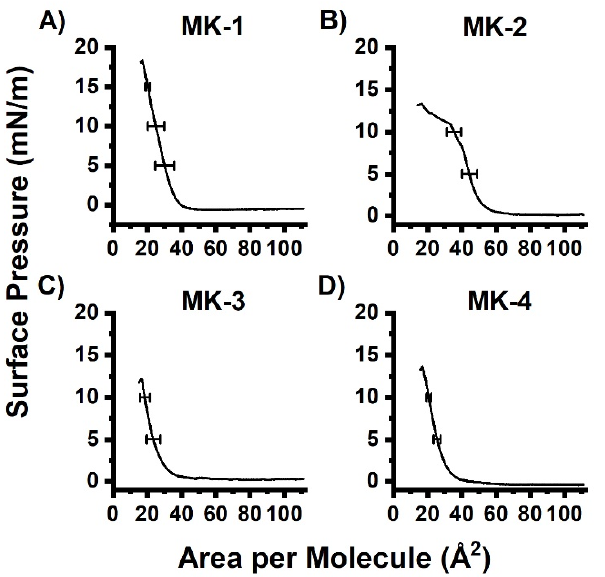
Figure 2. Compression isotherms of pure films of ( A ) MK-1, ( B ) MK-2, ( C ) MK-3, and ( D ) MK-4. Curves are the average of triplicate measurements. Error bars represent the standard deviation of the area.